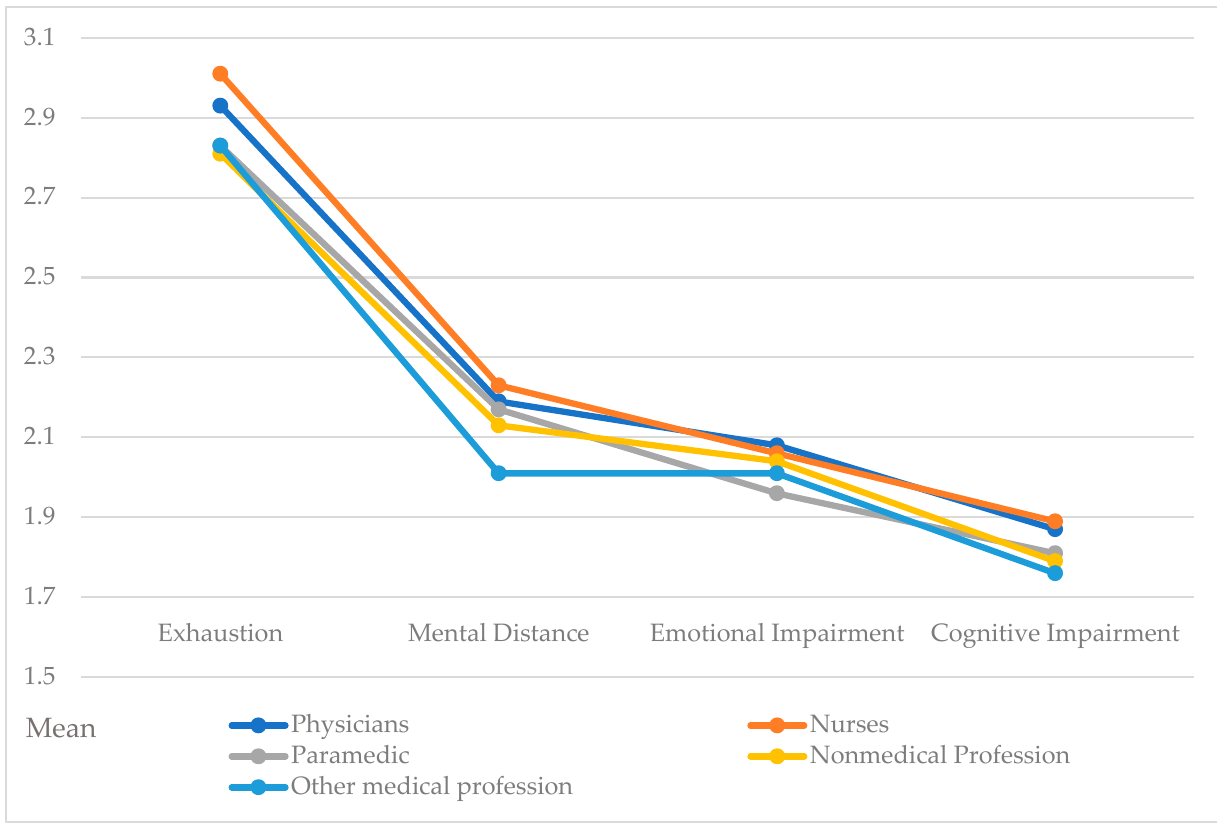
Figure 1. Occupational burnout profiles—mean percentage distributions for each dimension of occupational burnout by profession (N = 2196).